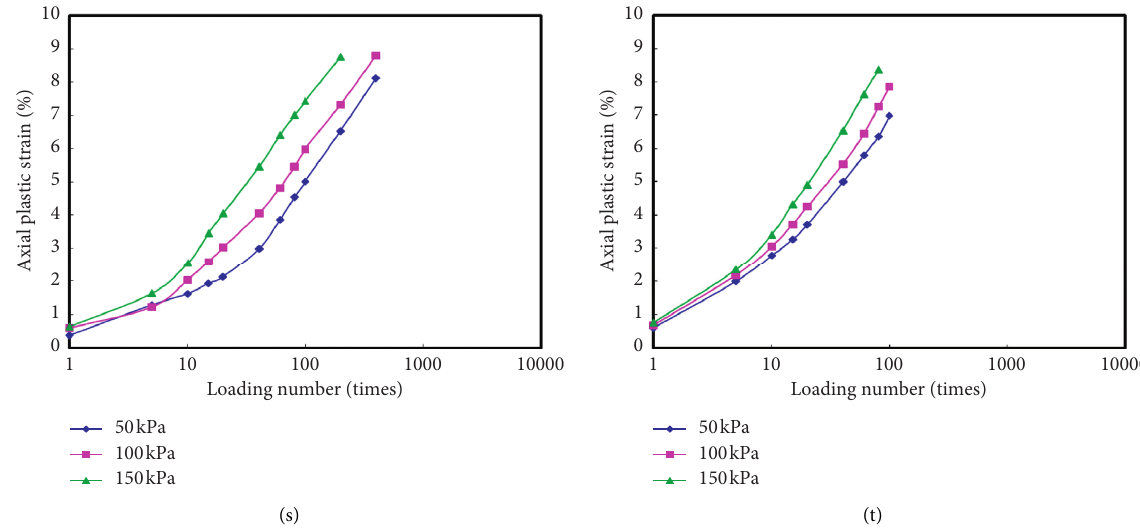
Figure 5: Relations between the axial strain and loading number under different confining pressures. (a) (s) � 0.1, GM, (b) (s) � 0.1, GF, (c)